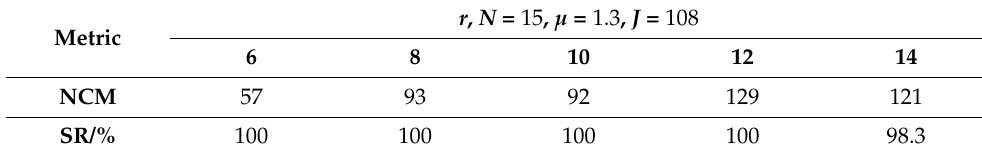
Table 6. The results of parameter r